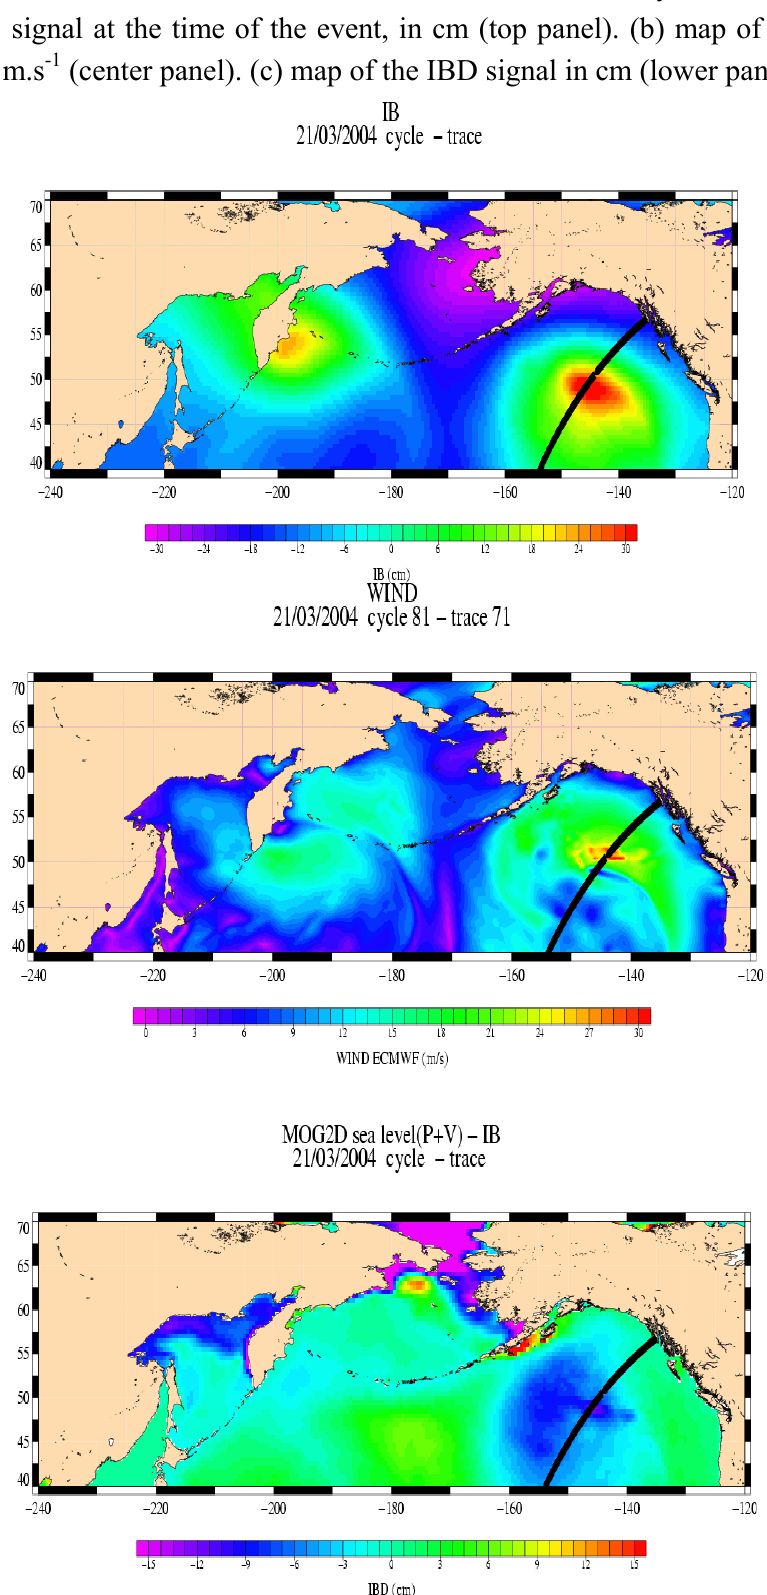
Figure 16. Case of 21/03/2004 over the North Pacific Ocean – J1 cycle 81 – track 71. (a) map of the IB signal at the time of the event, in cm (top panel). (b) map of the ECMWF wind speed in m.s -1 (center panel). (c) map of the IBD signal in cm (lower